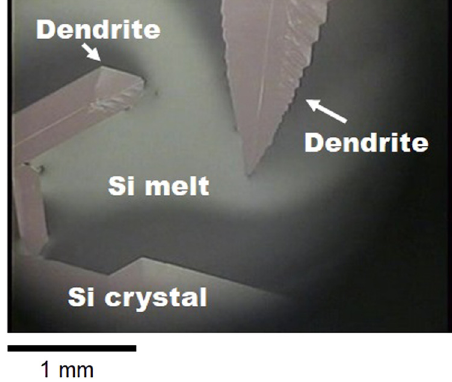
Figure 4: Dendrites growing in the Si